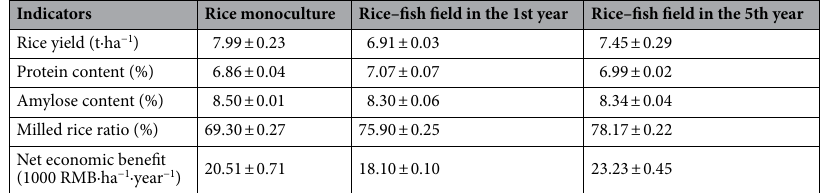
Table 4. The rice yield, quality indices and net economic benefit of different rice farming systems.